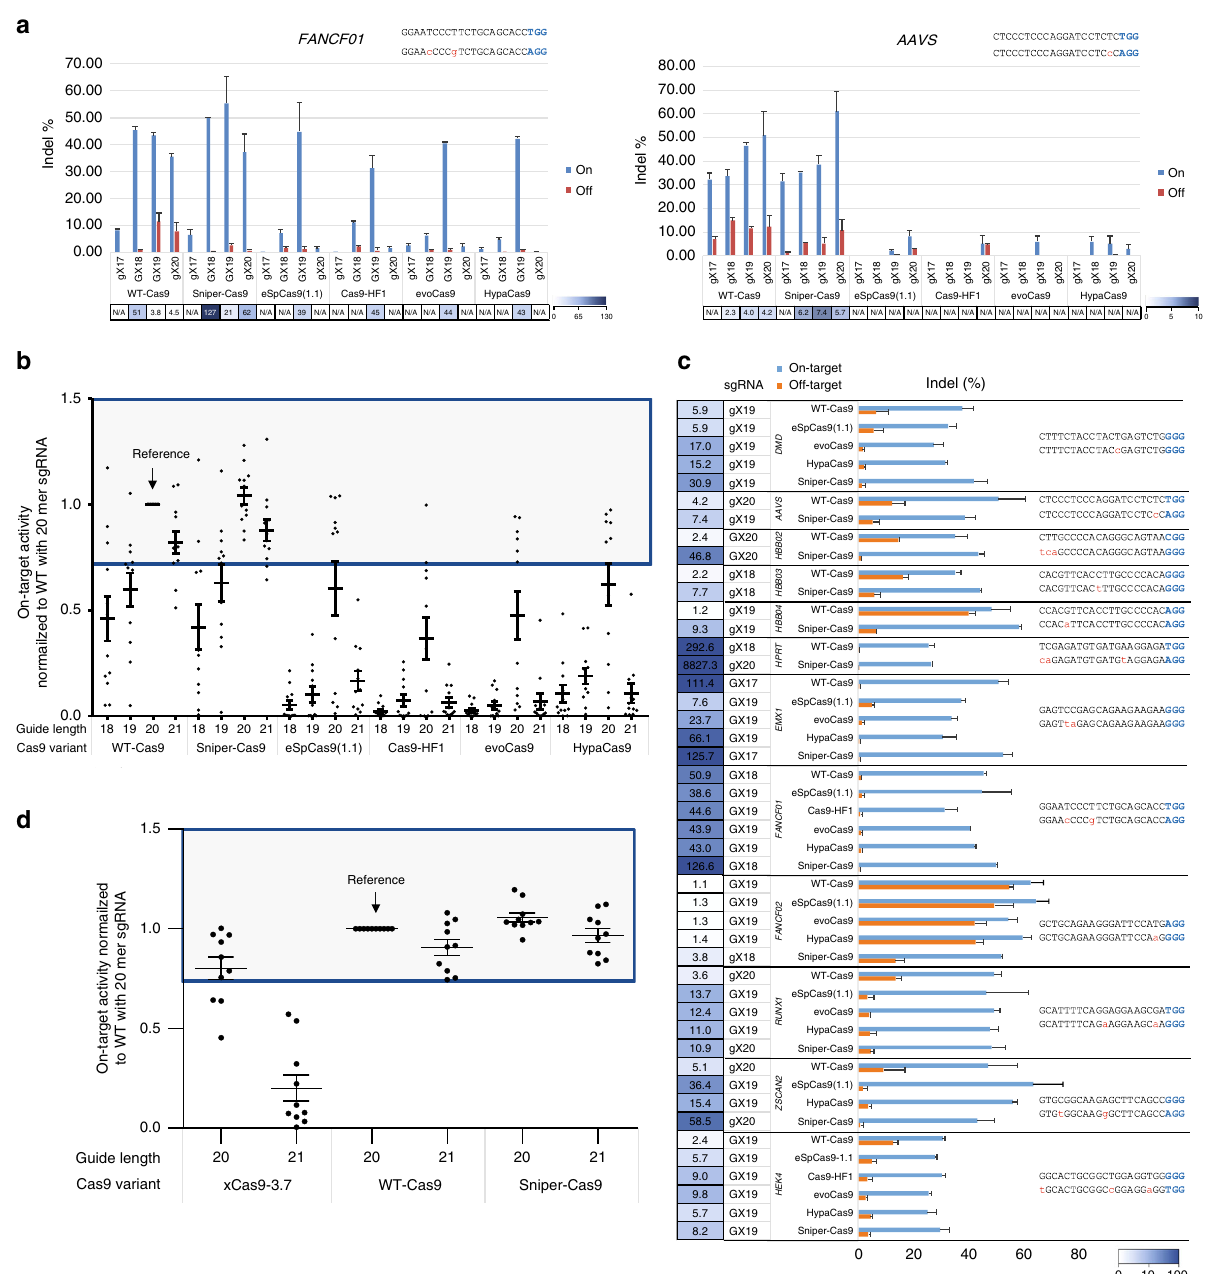
Fig. 2 Sniper-Cas9 retains WT-level on-target activities with diminished off-target activities. a On-target and off-target activities of Cas9 variants compared to WT-Cas9 using sgRNAs with variable lengths targeting the FANCF01 and AAVS sites. Speci fi city ratios were determined by dividing indel frequencies at on-target sites by those at the respective off-target sites. sgRNAs with a matched guanine at the 5 ′ terminus (GX18 or GX19) and those with a mismatched guanine (gX17, gX18, gX19, or gX20) are indicated. Speci fi city ratios were not calculated when the normalized on-target activities were <70%. b Dot plots of on-target indel frequencies normalized to those obtained with WT-Cas9 plus gX20 or GX20 sgRNAs. The gray-boxed area represents on-target activities higher than 70% of the WT-Cas9 activity. The numbers on the x axis represent the guide sequence length including the 5 ′ guanine; 18: gX17 or GX17, 19: gX18 or GX18, 20: gX19 or GX19, 21: gX20 or GX20. Error bars indicate s.e.m. ( n = 12). c On-target and off-target activities of Cas9 variant-sgRNA combinations with >70% on-target activity relative to WT-Cas9. Speci fi city ratios were determined by dividing the on-target activity by the off-target activity. For each target, sgRNAs with the highest speci fi city ratios are shown for each Cas9 variant. Error bars indicate s.e.m. ( n = 3). d Dot plots of on-target indel frequencies normalized to those obtained with WT-Cas9 plus gX20 or GX20 sgRNAs. The gray-boxed area represents on- target activities higher than 70% of the WT-Cas9 activity. The numbers on the x axis represent the guide sequence length including the 5 ′ guanine; 20: gX19 or GX19, 21: gX20 or GX20. Error bars indicate s.e.m. ( n = 10). N/A: not